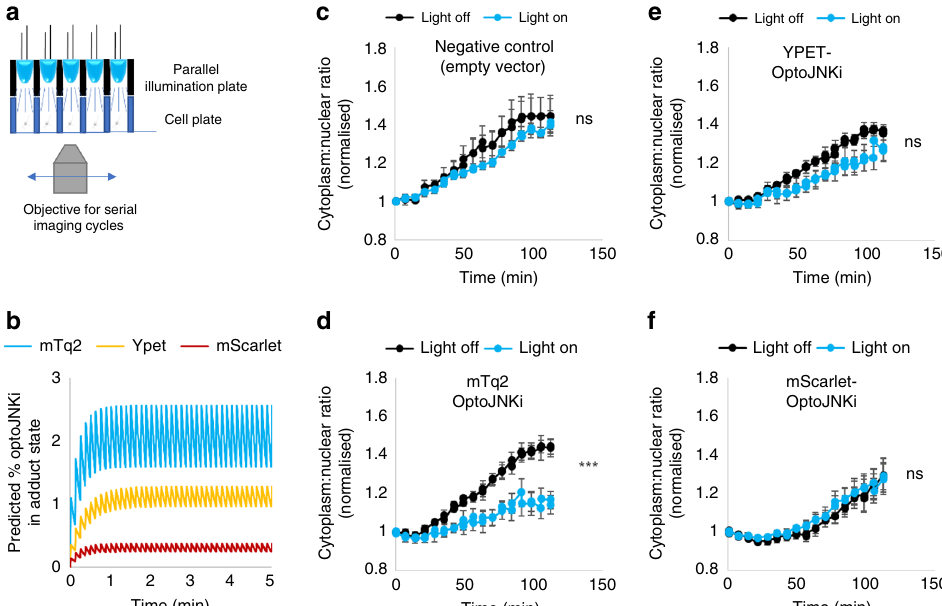
Fig. 7 Minimal illumination conditions suf fi cient to inhibit the JNK pathway inhibition with mTq2-optoJNKi and demonstrate fl uorescent tag- dependent sensitivity of actuation. a To evaluate activation of the JNK pathway in real-time, multipoint epi- fl uorescence microscopy of neurons expressing JNK reporter was carried out during trans-illumination of selected wells by blue LEDs gated by microscope imaging acquisition. b Based on parameters from Table 1, and a 1 s 0.06 mW/cm 2 fl ash of blue light every 7.5 s, the % of construct in adduct state stabilises after about 1 min as shown. The mTq2 construct reaches approximately fi vefold greater proportion in adduct state compared with the Ypet construct, whereas the mScarlet construct exhibits minimal adduct state under these conditions. c – f Changes in cytoplasm:nuclear ratios of the JNK pathway reporter JNKktr (increased translocation from the nucleus indicates activation of JNK) are shown in response to treatment with JNK-activator anisomycin. Cultured cortical neurons were infected with AAVs encoding synapsin-promoter driven JNKktr fused to miRFP670 and optoJNKi fused to either mTq2, Ypet or mScarlet as shown. The light-on samples (turquoise datapoints) were exposed to light as shown in a . The mTq2-optoJNKi expressing neurons exhibited signi fi cant light-dependent inhibition, the Ypet-optoJNKi had a barely detectable and not signi fi cant effect in response to light whereas the mScarlet-optoJNKi expressing cells did not respond to light. This is consistent with the predictions shown in b . Means ± SEM ( n = 4 wells) are shown. *** P < 0.001, ns denotes non-signi fi cance, by two-way ANOVA. Source data are provided as a Source Data fi